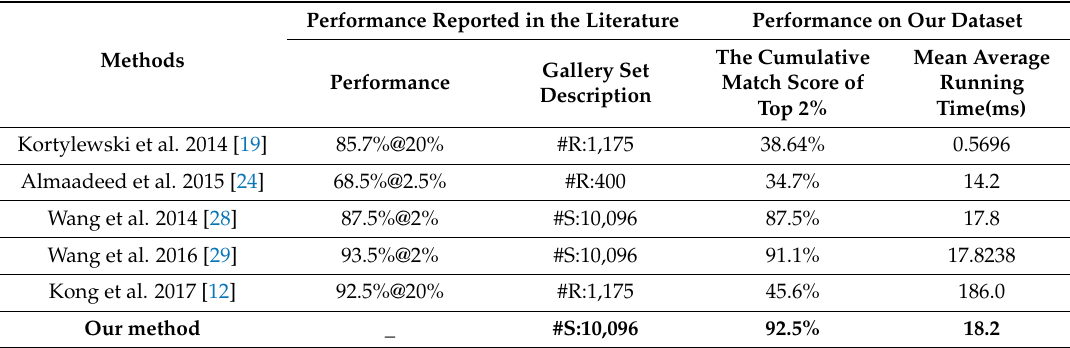
Table 4. Comparisons with the state-of-the-art algorithms on the MUES-SR10KS2S